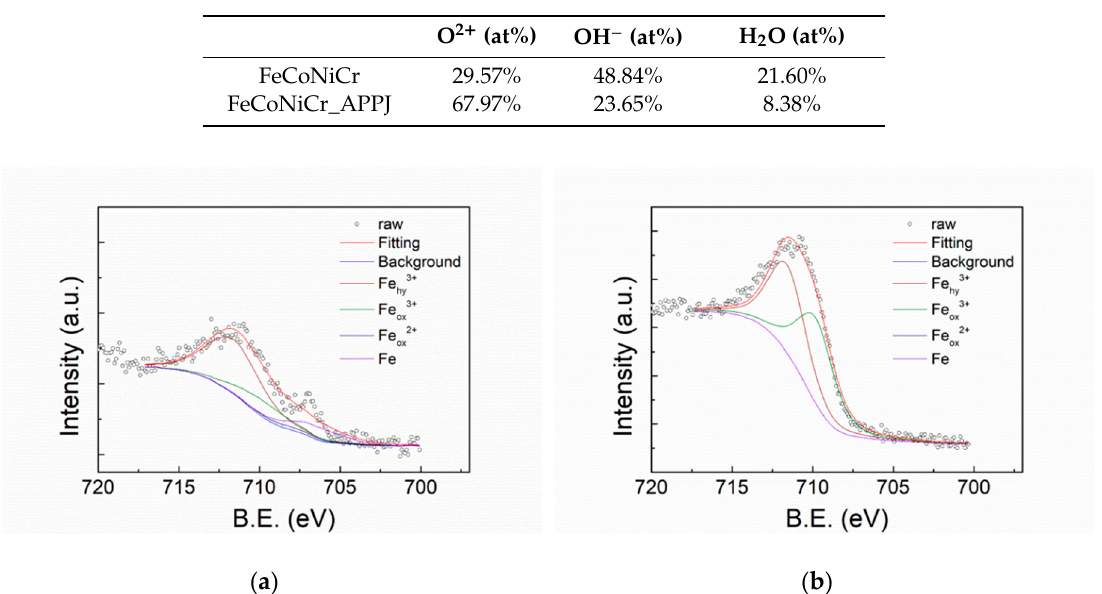
Figure 7. XPS O1s spectra of ( a ) FeCoNiCr and ( b ) APPJ-treated FeCoNiCr MEAs. Table 3. XPS O1s deconvoluted peak areal ratios from XPS spectra shown in Figure 7.